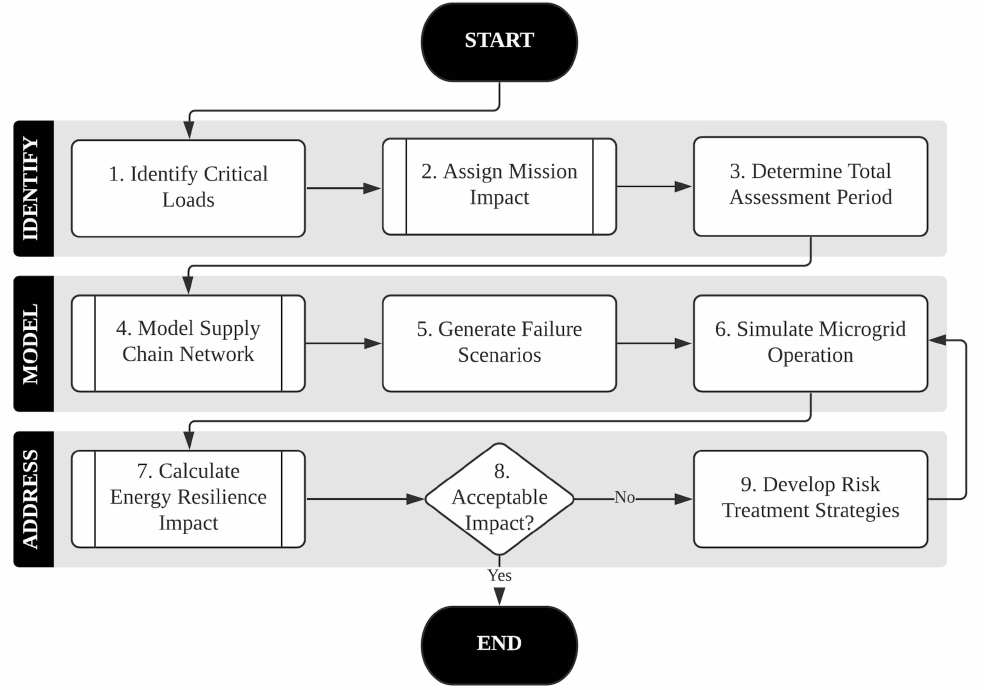
Figure 4. Methodology overview. This method is offered as an evaluative tool to assist IEMs in minimizing microgrid susceptibility to supply chain disruption